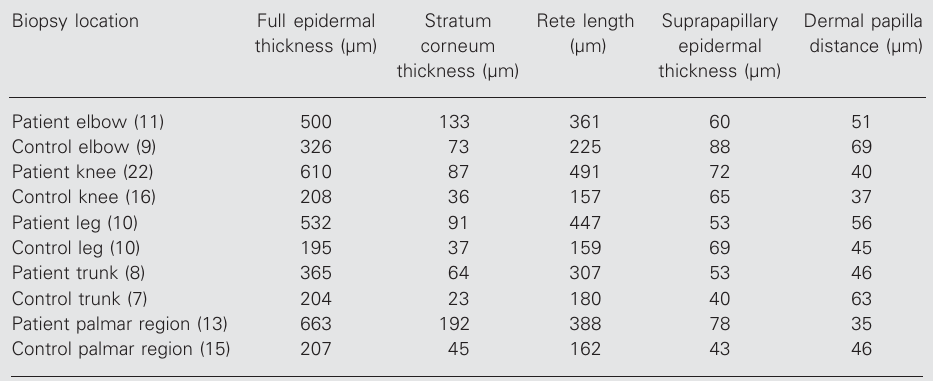
Table 2. Epidermal thickness measurements of psoriasis patients and controls according to biopsy location. Biopsy